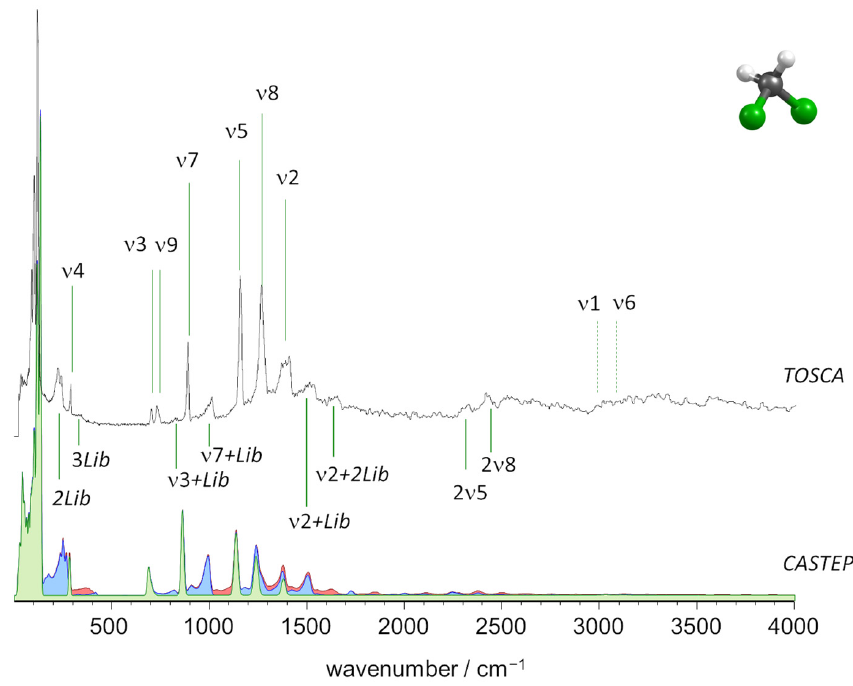
Figure 4. The INS spectra of dichloromethane up to 4000 cm − 1 : Experimental (top, TOSCA) and simulated from periodic calculations (bottom, CASTEP). Colors indicate the intensity contributions from fundamental modes (green), two-quanta events (blue) and three-quanta events (red).